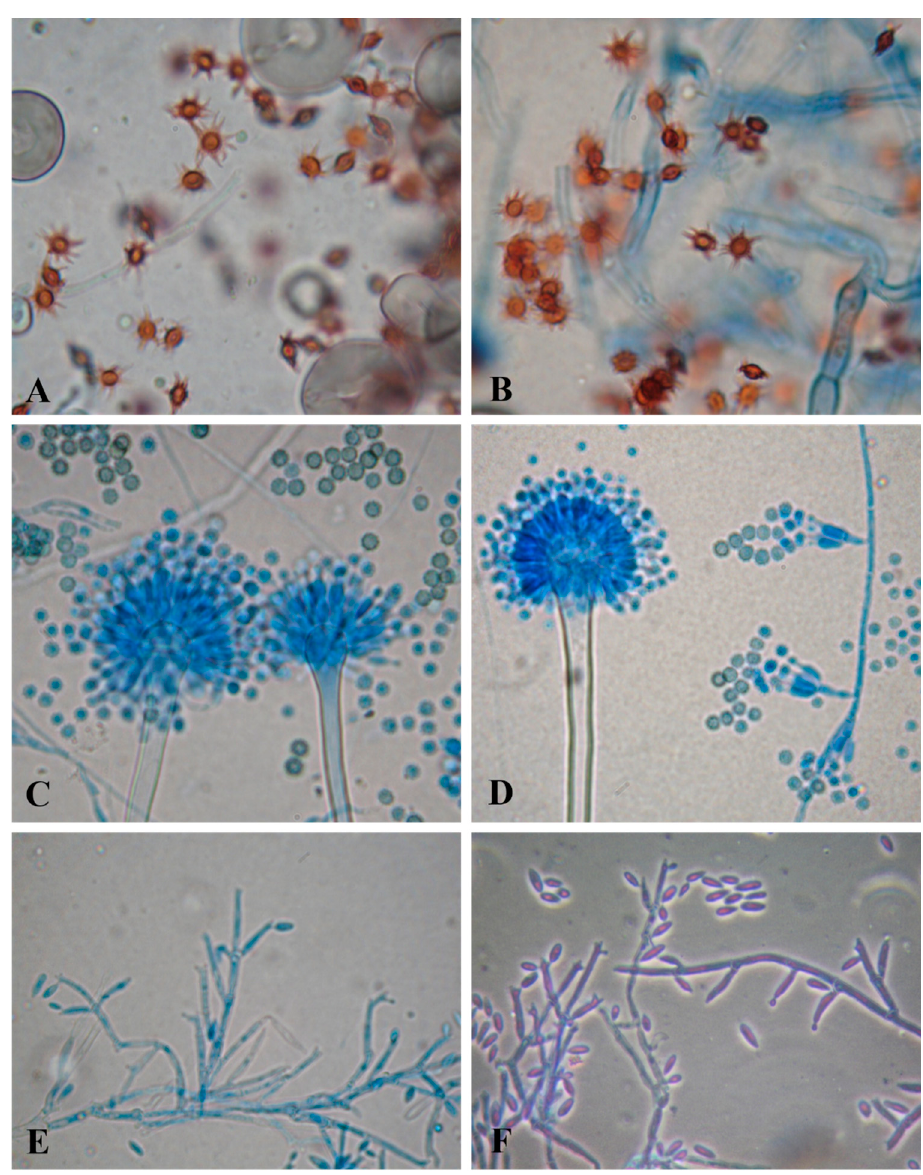
Figure 1. Light brown spores of A. stelliformis ( A , B ), biseriate conidiophores, and spinulose conidia of A. sydowii ( C , D ), and relatively curved and fusiform microconidia of F. brachygibbosum originated from mono and polyphialides ( E , F ).